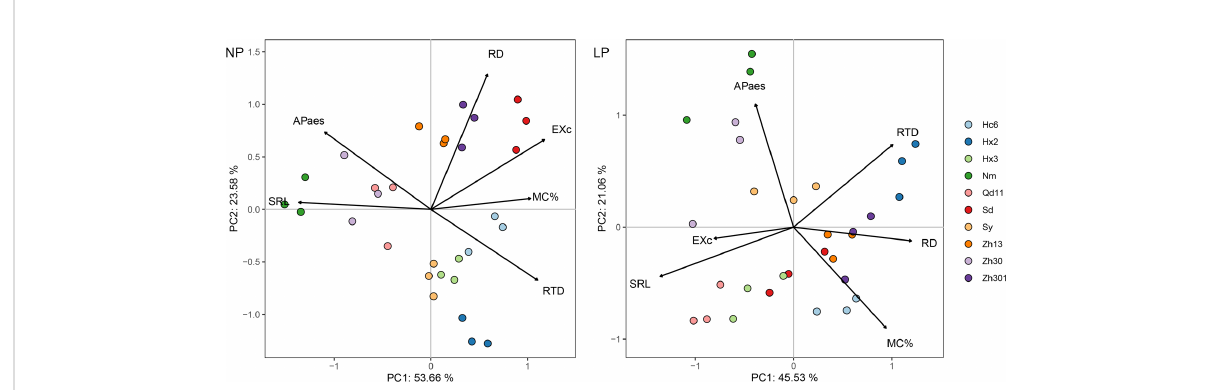
FIGURE 2 Principal component analysis of root functional traits for 10 varieties in response to normal (NP) and low (LP) soil phosphorus levels. Root trait RD, average diameter of roots; SRL, speci fi c root length; RTD, root tissue density; MC%, colonization by arbuscular mycorrhizal fungi; EXc, amounts of carboxylates in the rhizosheath; APase, acid phosphatase activity in the rhizosheath. Varieties abbreviation: Qd11, Qian Dou 11; Zh13, Zhonghuang 13; Nm, Niu Mao Soybean; Sd, Shang Dou 1013; Qx1, Qixing 1; Hc6, Hua Chun 6; Zh30, Zhonghuang 30; Hx3, Hua Xia 3; Ax, Ai Xuan; Hx2, Hua Xia 2; Sy, Suiyang bean; Zh301, Zhonghuang 301; and Zh61, Zhonghuang